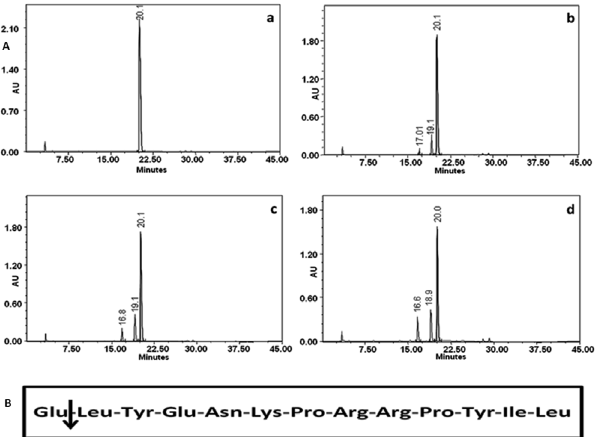
Fig 7. Hydrolytic specificity of cupincin on neurotensin. (A). RP-HPLC profile showing the blank neurotensin (a). Cleavage pattern of neurotensin hydrolyzed by cupincin at 2hours (b), 4hours (c) and 6 hours (d) of incubation. The peptides were resolved using a Grace Vydac C-18 column (4.6 × 250mm). The solvents used were 0.1% TFA and 70% acetonitrile containing 0.05% TFA. The peptides were detected at 230 nm. (B). Amino acid sequence of neurotensin, arrow indicating the cleavage position of